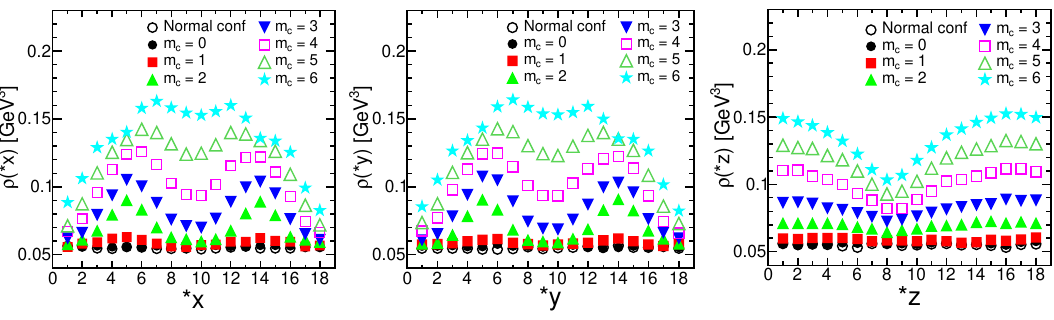
Figure 1 . The monopole density on the dual-site ( (cid:3) x; (cid:3) y; (cid:3) z ). The normalization factor V is l 2